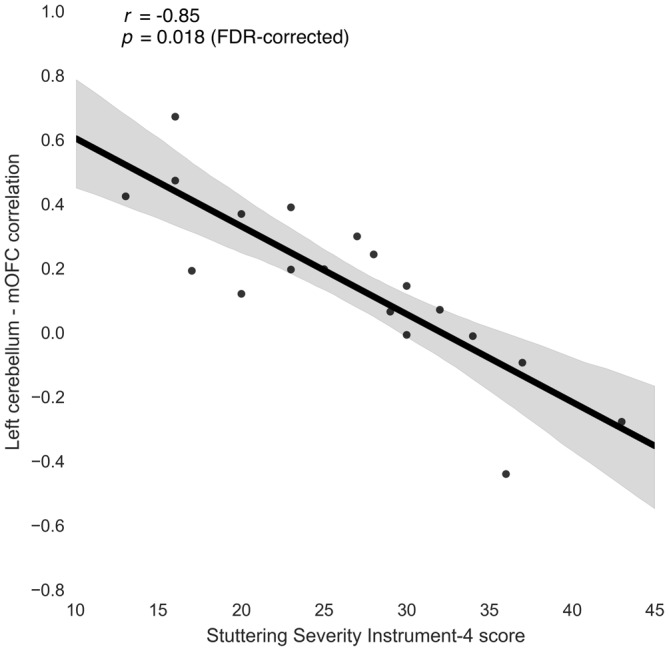
Relationship between stuttering severity instrument-4 (SSI-4) and left cerebellum-medial orbitofrontal cortex (mOFC) functional connectivity in people who stutter.